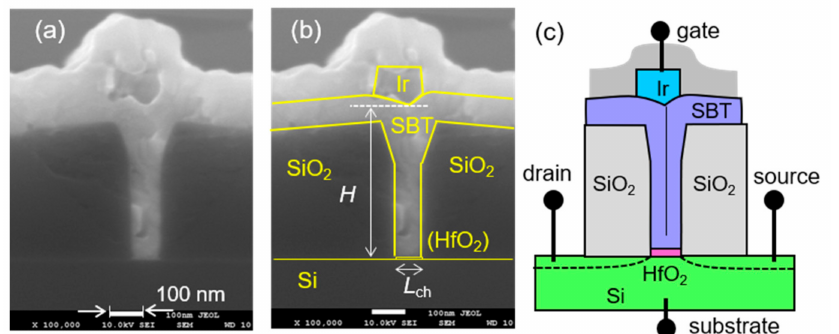
Figure 3. Cross-section of a FeFET with L ch = 85 nm fabricated in this work. ( a ) Original photo by SEM observation and ( b ) the photo with supporting lines added to clarify material boundaries. ( c ) Schematic drawing assigned with gate, drain, source and substrate terminals for electrical